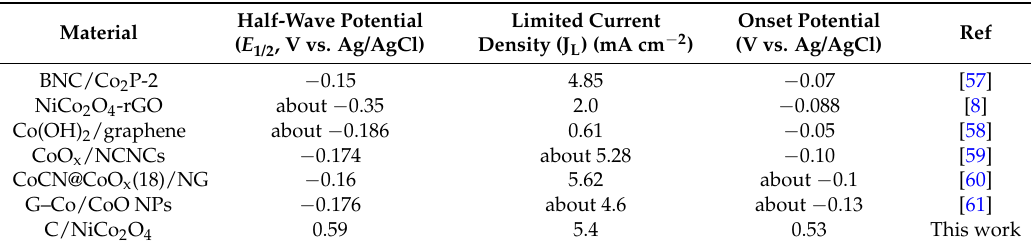
Table 1. Summary of E 1/2 , diffusion-Limited current density (J L ), and onset potential reported for different electrocatalysts at an electrode rotational speed of 1600